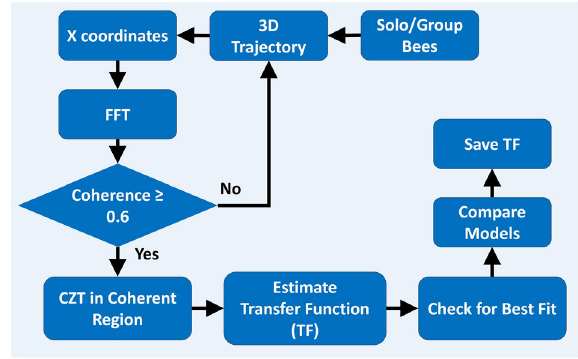
Figure 12. Frequency-domain system identification